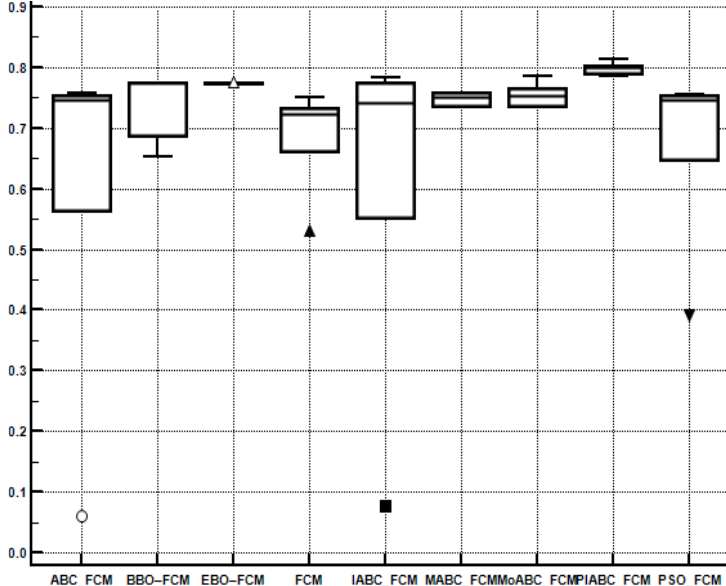
Figure 8. Box-whisker graph to present the outcomes of the PC index.